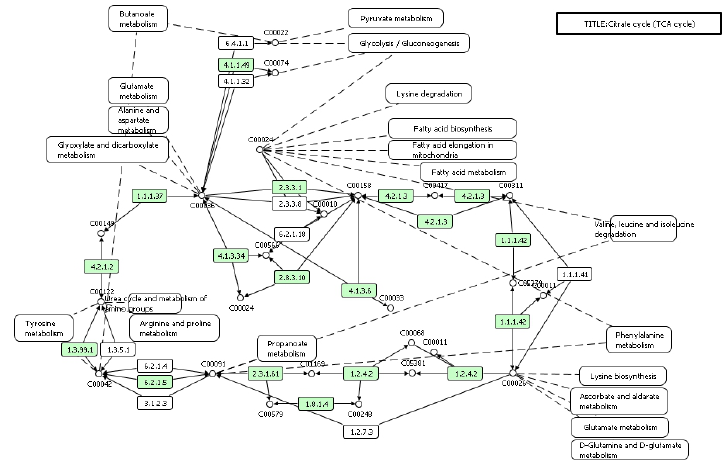
Figure 8: The TCA cycle of Escherichia coli visualized in VANTED